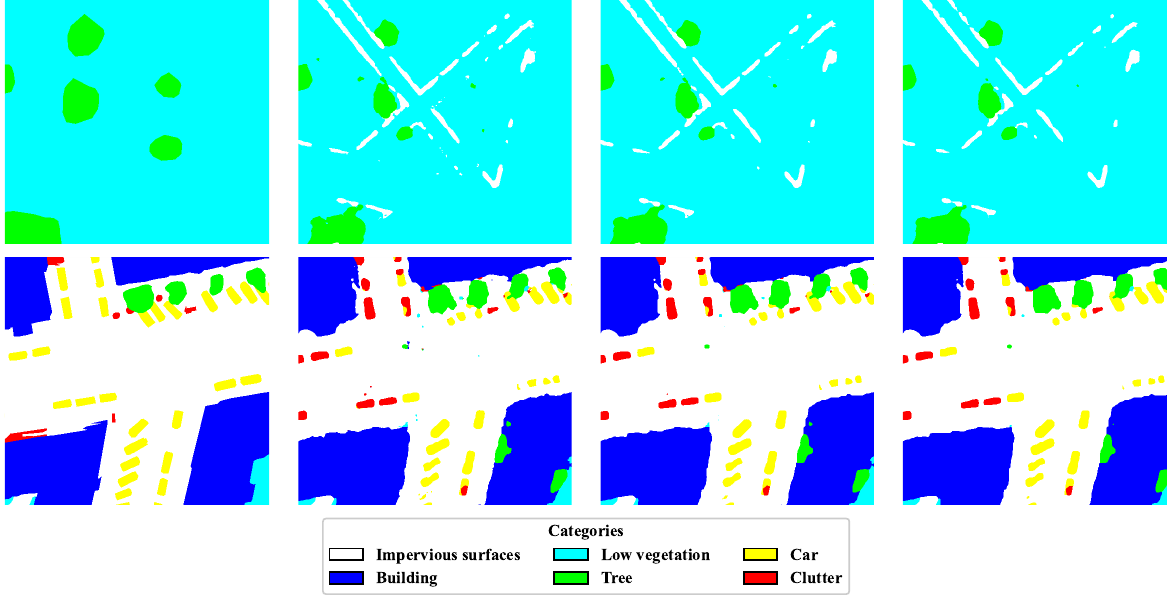
Table 1. F1 value [%] of semantic segmentation for the classes Impervious surface, building, low vegetation, tree, car and clutter. Additionally, the overall accuracy (OA) is specified. Improvements by MRF-based methods are bold. Label image